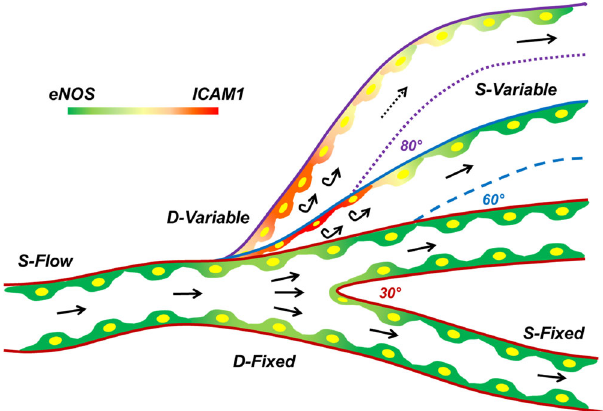
Fig. 7 Differential angular branching points of a human coronary artery cause varying degrees of fl uid fl ow turbulence consequently switching EC towards pro-atherogenic phenotypes. Vessel branch points are known to affect the WSS levels, cause endothelial dysfunction and thus are the